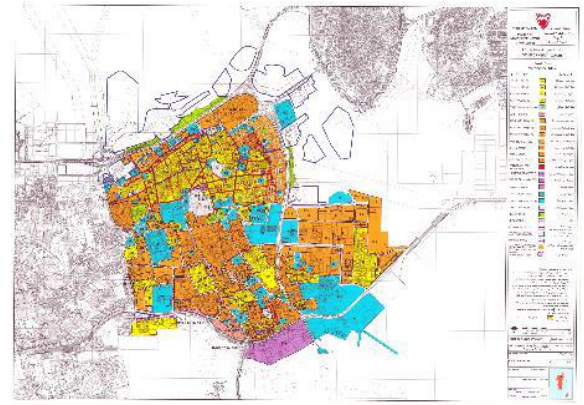
Figure 2. A map of Manama governorate clearly show the old district, Bahrain, in 2016s, Ministry of Municipalities Affairs and